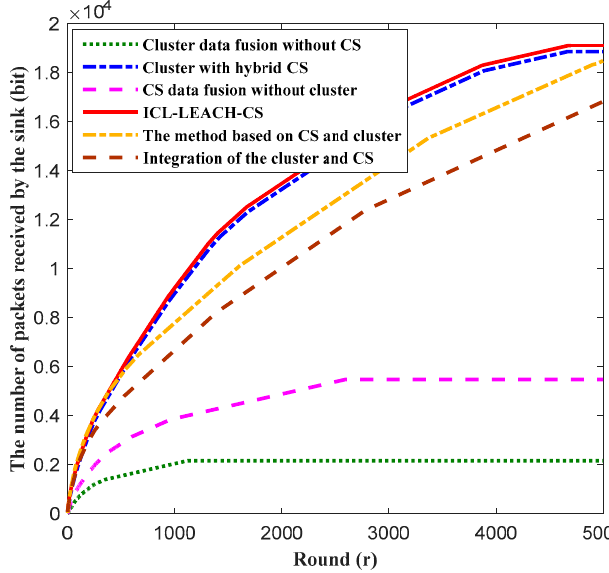
Figure 15. Data transmission at the sink node vs. round.